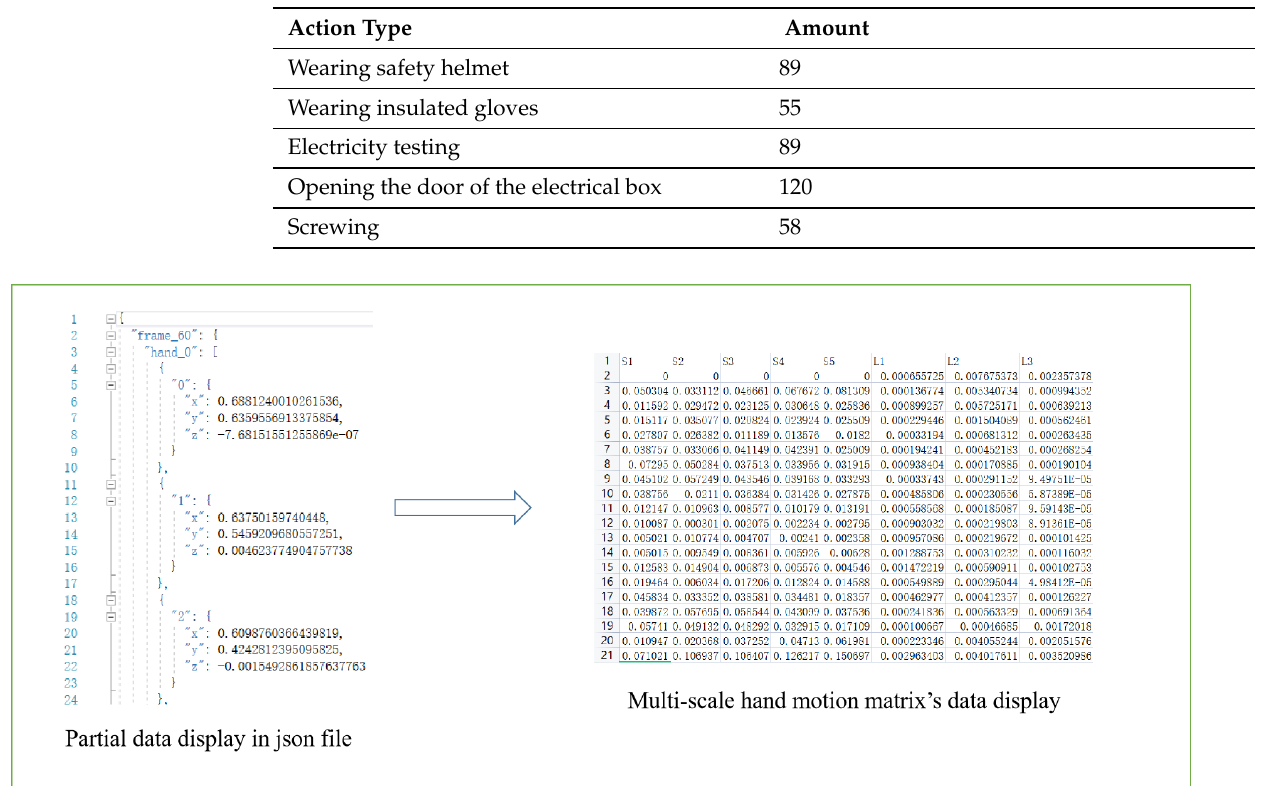
Table 1. Action Distribution of the Original Data Set.